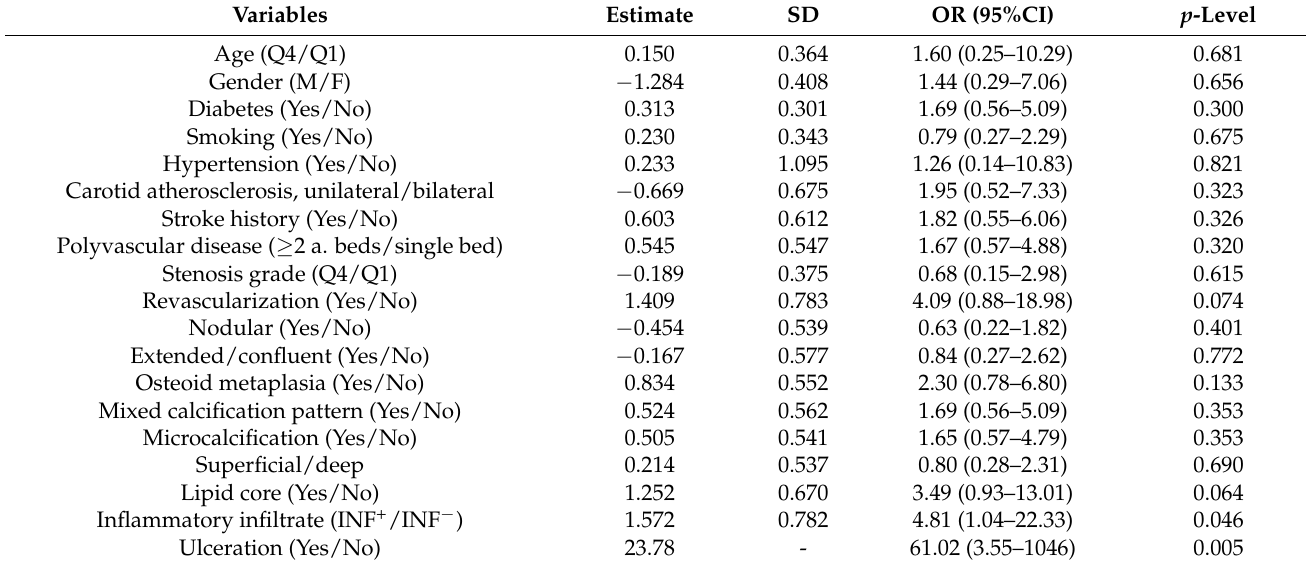
Table 5. Univariate logistic regression of variables associated with thrombosis of the plaque.